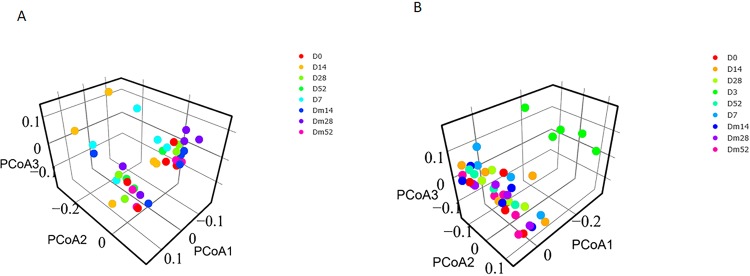
Beta diversity: Principal coordinates analysis (PCoA) plot based on unweighted Unifrac distances.(A) Cecal samples. (B) Fecal samples.